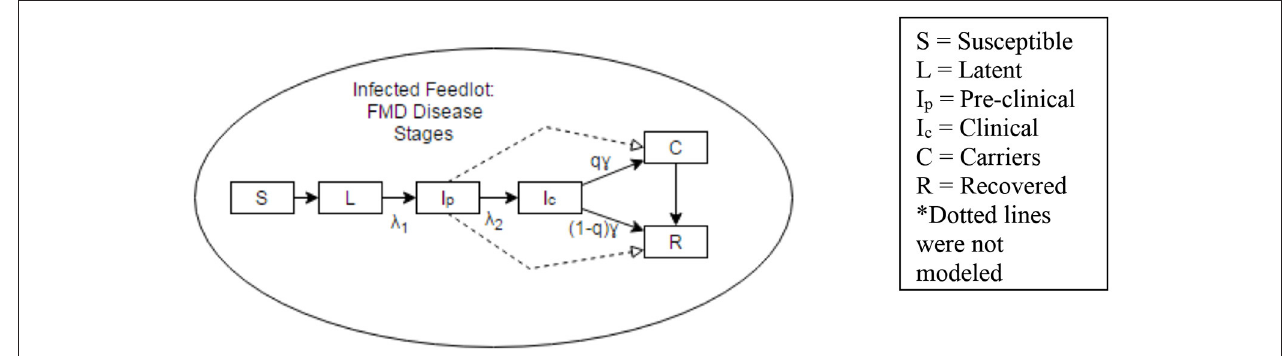
FIGURE 1 | Representation of disease states considered in a within-herd disease spread model. Dotted lines were not considered in the